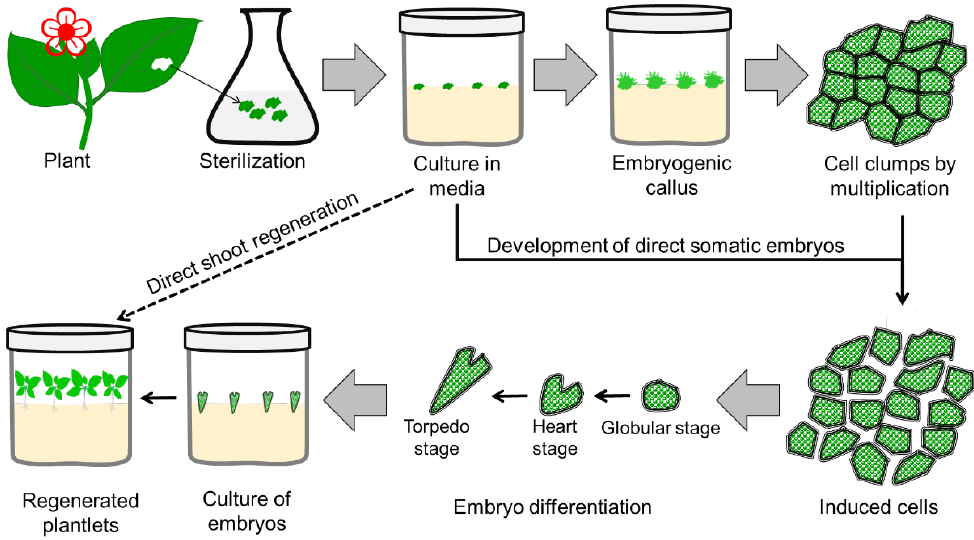
Figure 3. Diagrammatic presentation of the steps involved in somatic embryogenesis for mass propagation in plants. propagation in